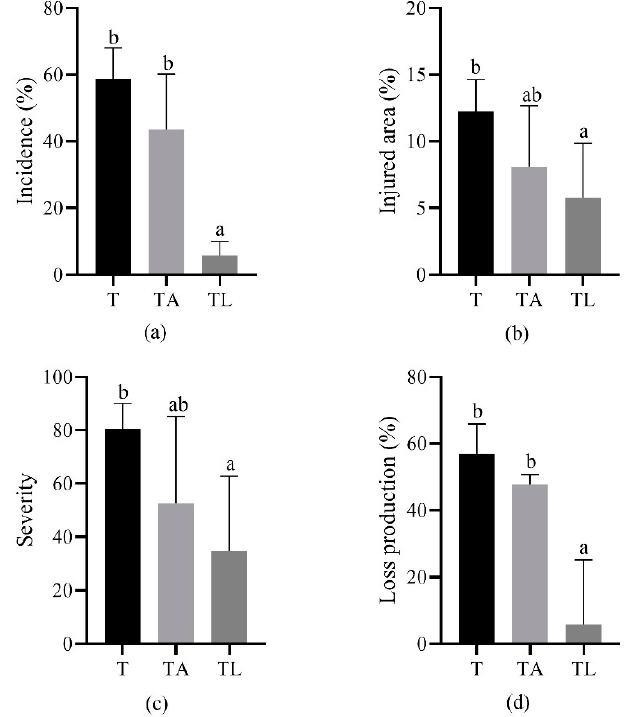
Figure 1. ( a ) Injured tuber incidence, ( b ) potato common scab-injured superficial area, ( c ) disease severity index, and ( d ) production loss (%) as a function of biocontrol agents. TA = T. asperellum , TL = T. longibrachiatum , T = control. Mean values followed by the same alphabets did not differ significantly based on Tukey’s test ( p < 0.05); CV (%): ( a ) 21.4, ( b ) 53.5, ( c ) 48.27, ( d ) 36.69.